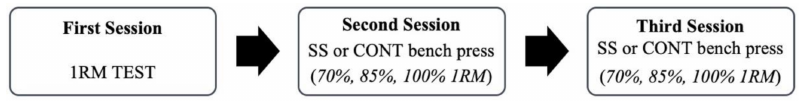
Figure 1. Schematic representation of the experimental sessions